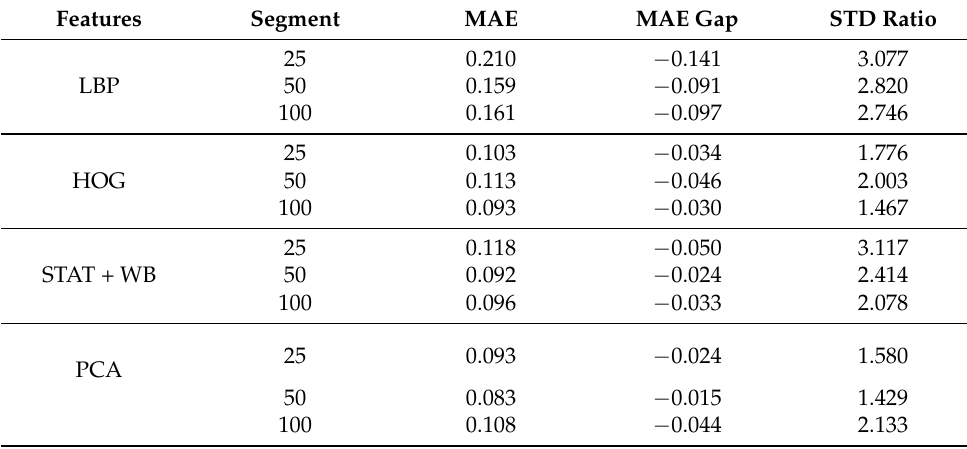
Table 4. Comparison Results between CNN and AI